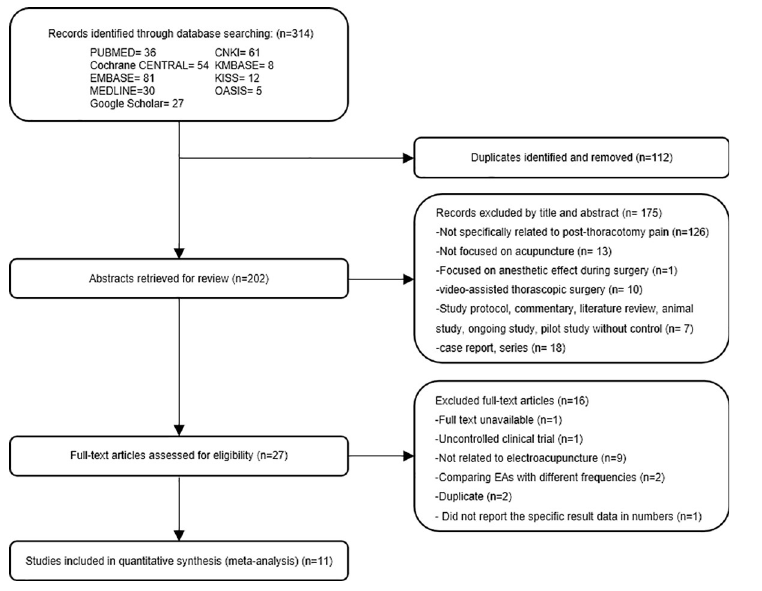
Fig 1. Flow diagram of the study selection